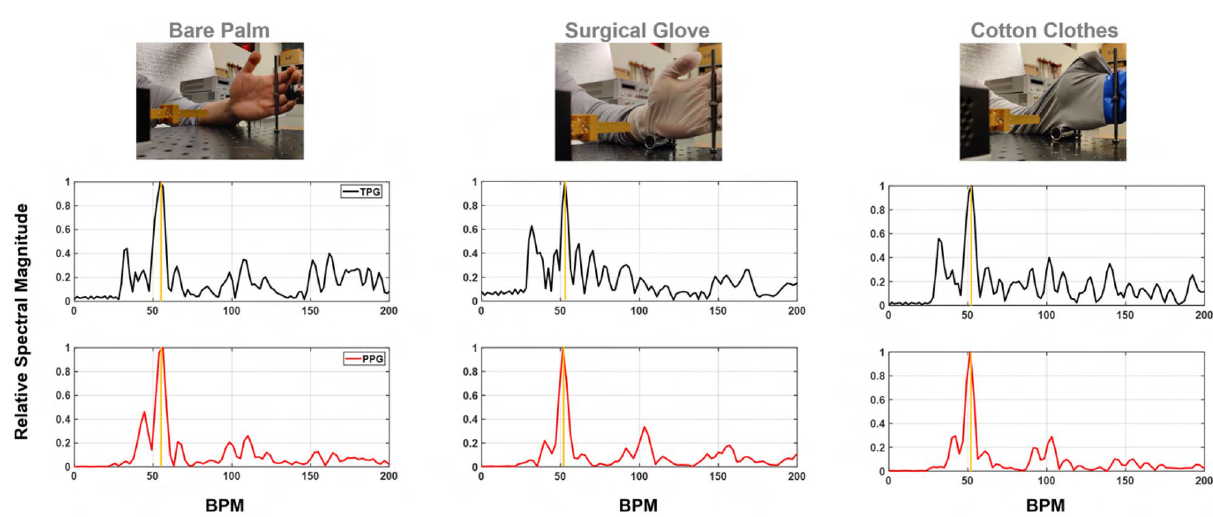
Figure 14. TPG penetration demonstration by comparing TPG spectra against the PPG reference